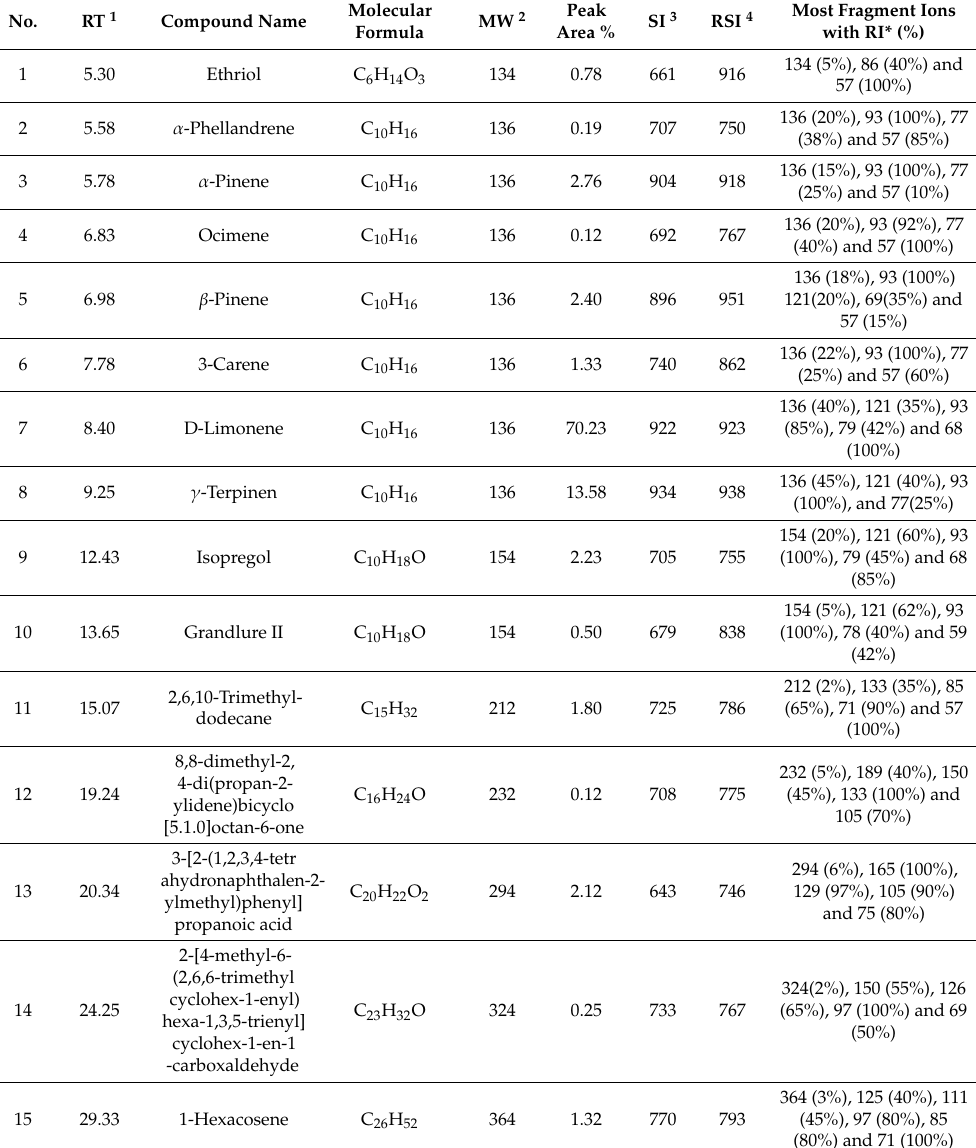
RI* relative intensities, 1 . RT: Retention Time 2 . MW: Molecular Weight (g / mol), 3 . SI: Standard Index, 4 . RSI: Reverse Standard